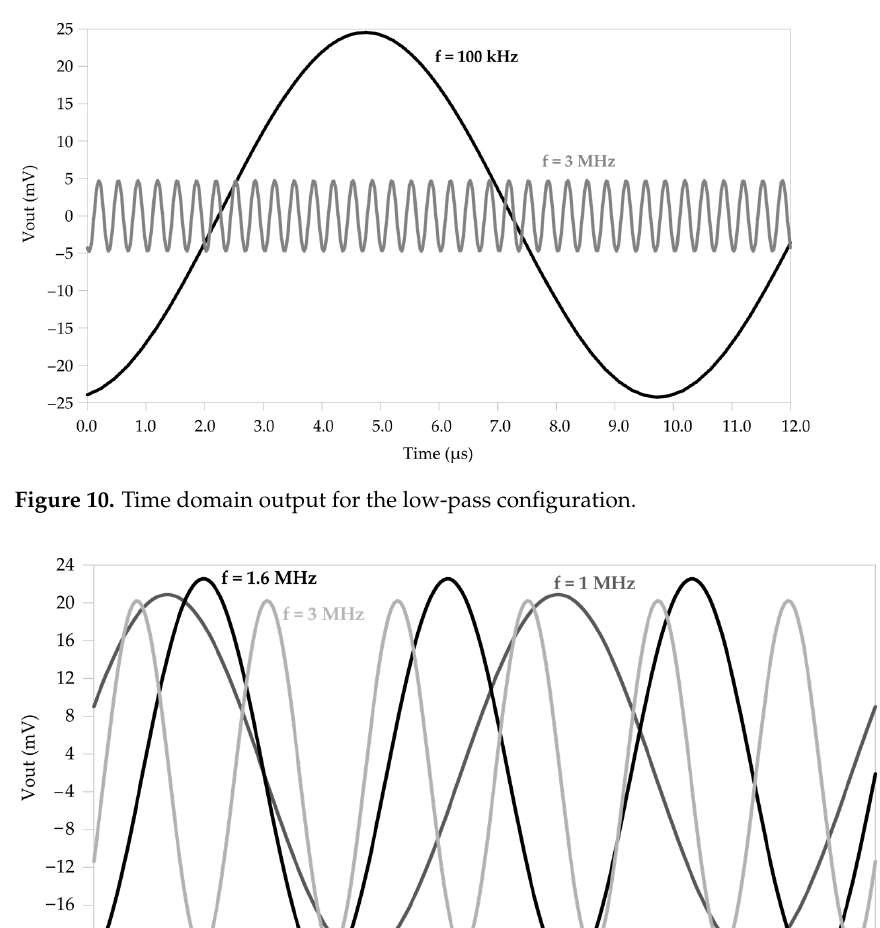
Figure 11. Time domain output for the band-pass configuration.